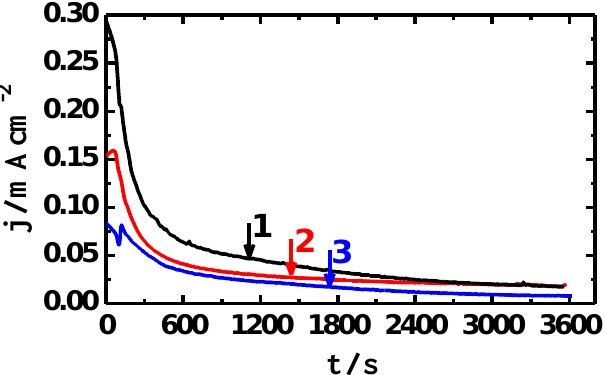
Figure 9. Chronoamperometric curves obtained for (1) hot swaged; (2) annealed at 800 °C; and (3) annealed at 940 °C Ti-45M electrodes after their immersions in 2 M HCl for 24 h, respectively, followed by stepping the potential to +1.4 V vs. Ag/AgCl for 1.0 h.